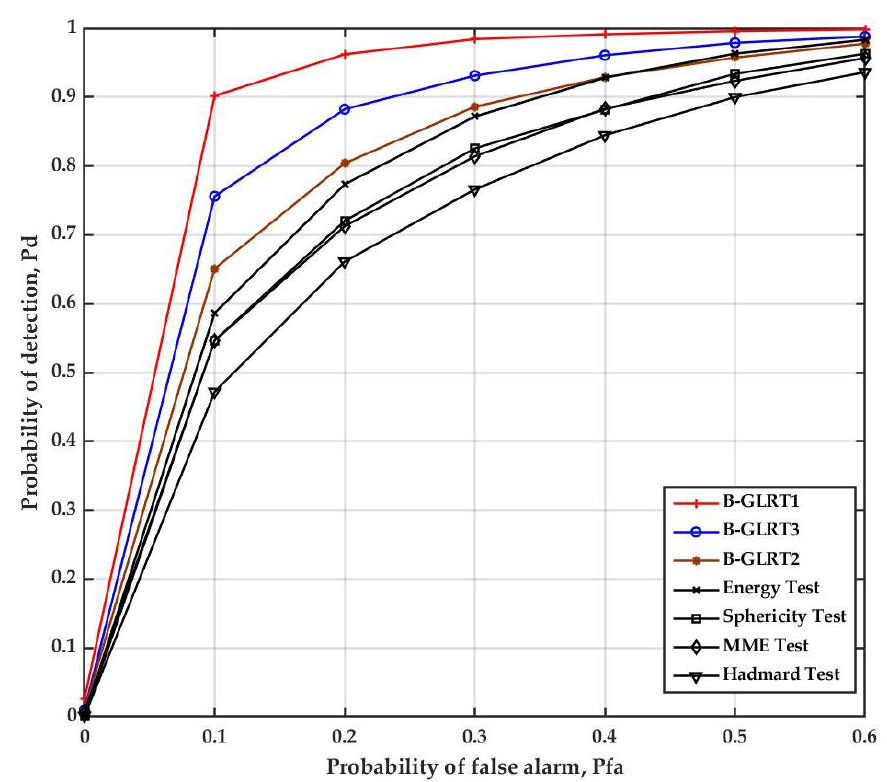
Figure 7. Probability of detection against probability of false alarm at SNR = – 3 dB, N r = 5, N t = 3 and L =